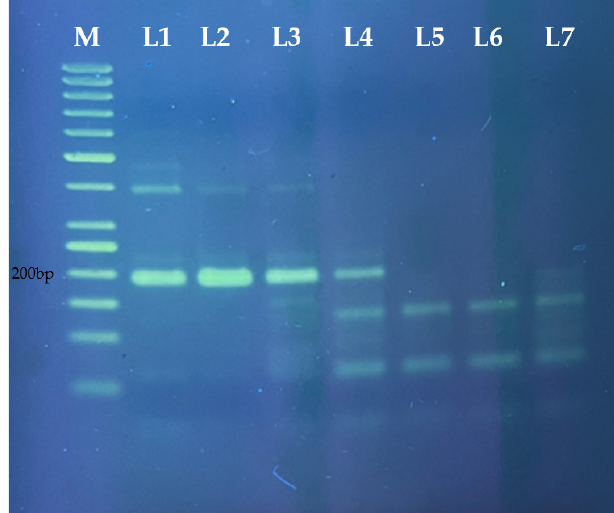
Figure 3. Electrophoresis profiles of RPA products amplified with porcine-specific RPA assay from the corresponding different amounts of DNA (M—50 bp DNA ladder, L1:10, L2:1, L3:0.1, L4:0.01, L5:0.001, and L6:0.0001) ng/µL with no template control (L7).